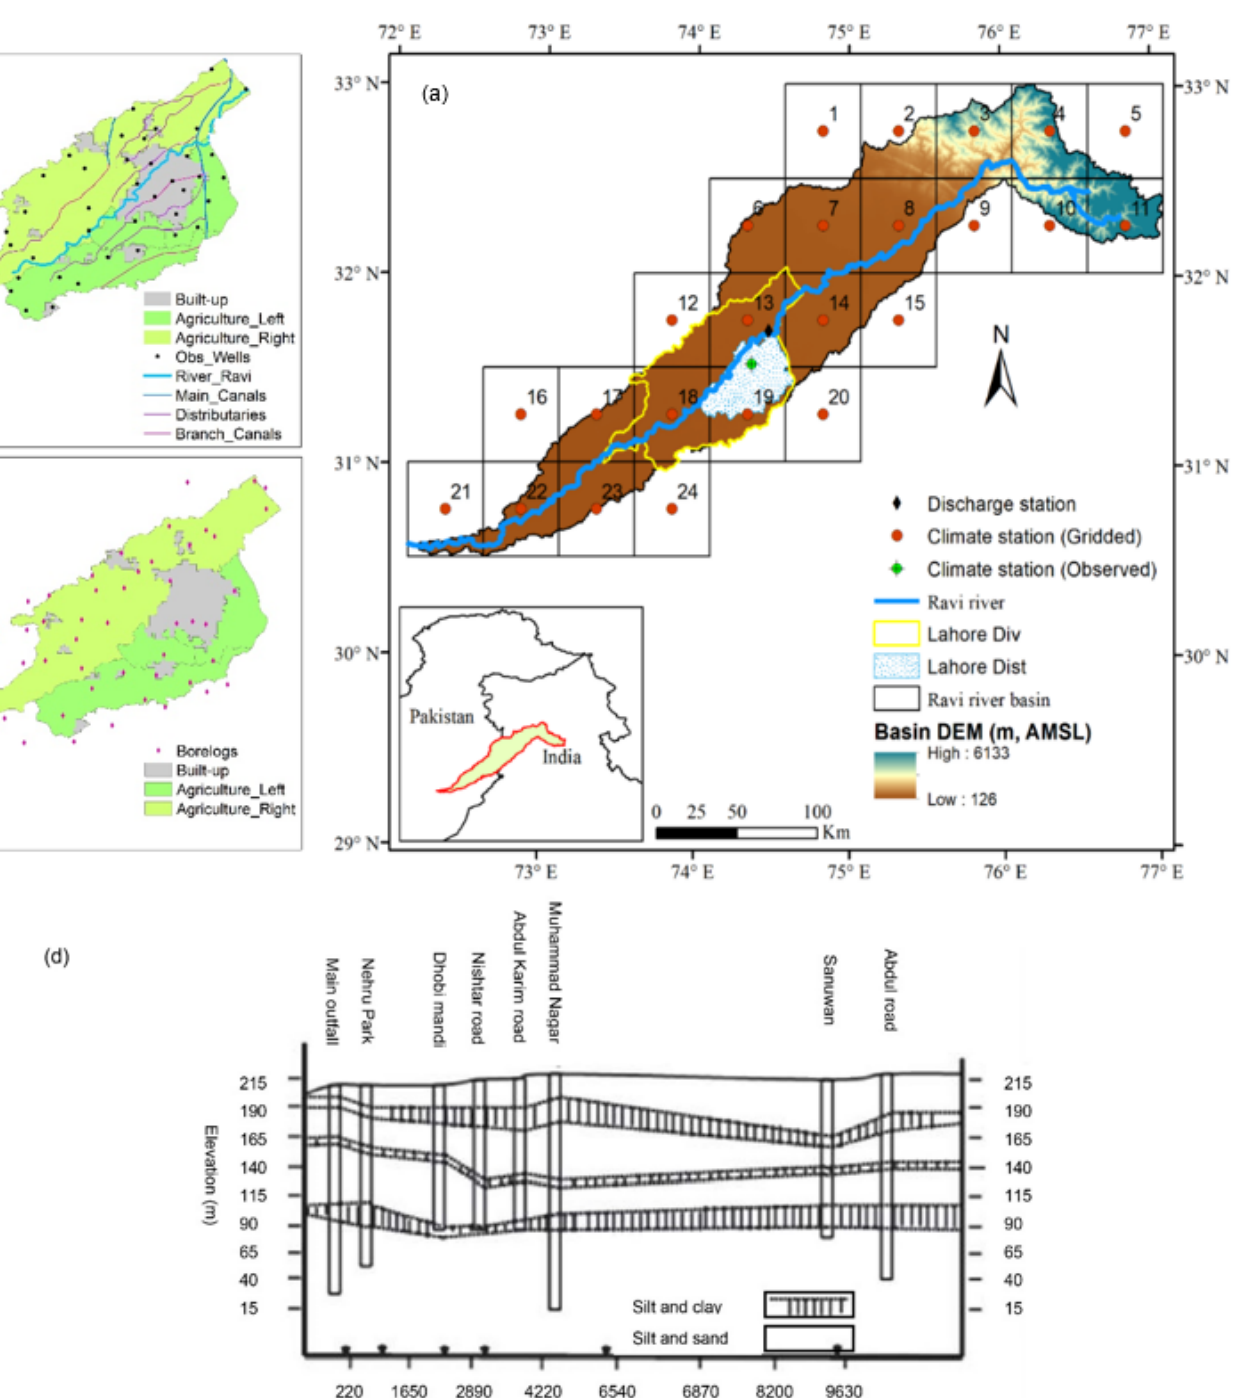
Figure 1. The geographic location of RRB. Topography is based on ASTER data. Climate stations (observed and virtual) are shown together with the 0.5° × 0.5° grid points ( a ). Three zones of Lahore division (Urban and Agriculture), river, canals, and observation wells are shown in ( b ). Bore-logs and their locations are shown in ( c ). Lithological classification of Lahore division aquifer in ( d ), [14].